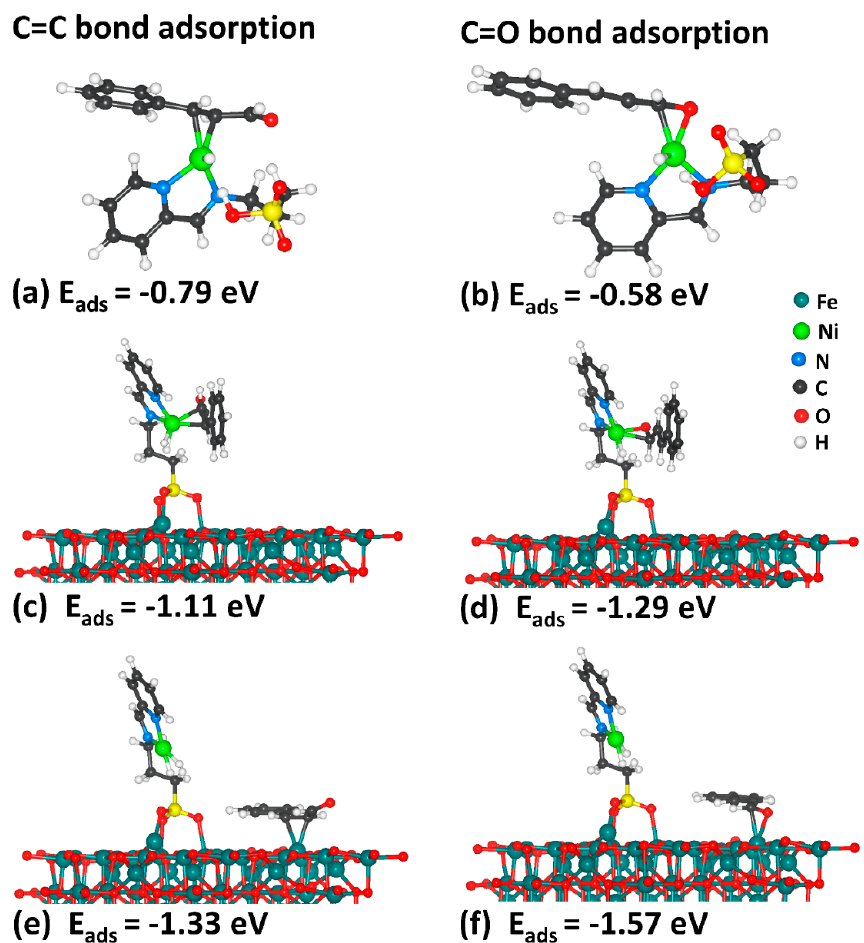
Figure 8. Optimized adsorption geometries and energetics (E ads ) of CAL on the homogeneous catalyst via ( a ) C=C bond and ( b ) C=O bond; on the heterogeneous catalyst via C=C bond ( c , e ) and C=O bond ( d , f ) at the Ni site and on the magnetite support.